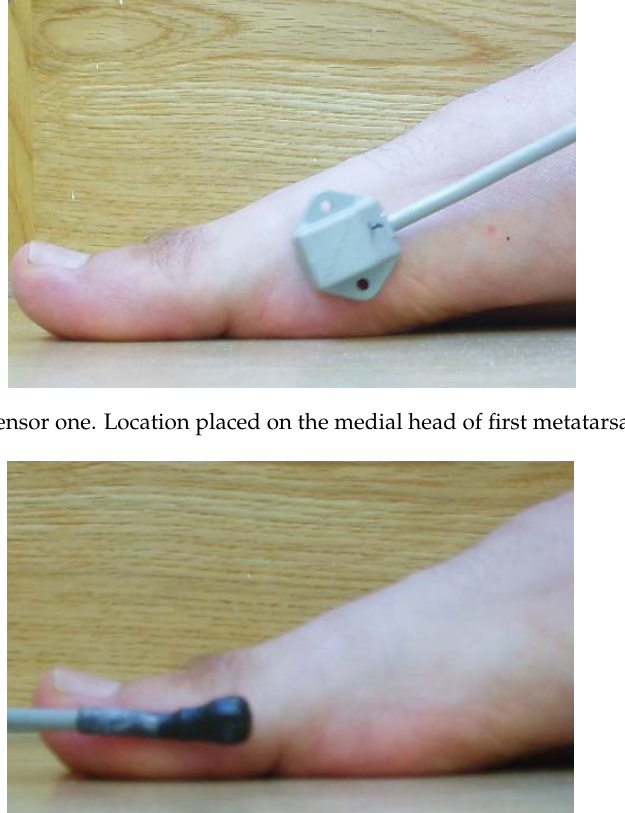
Figure 1. Polhemus device. From left to the right: sensors, receiver module, emitter module.